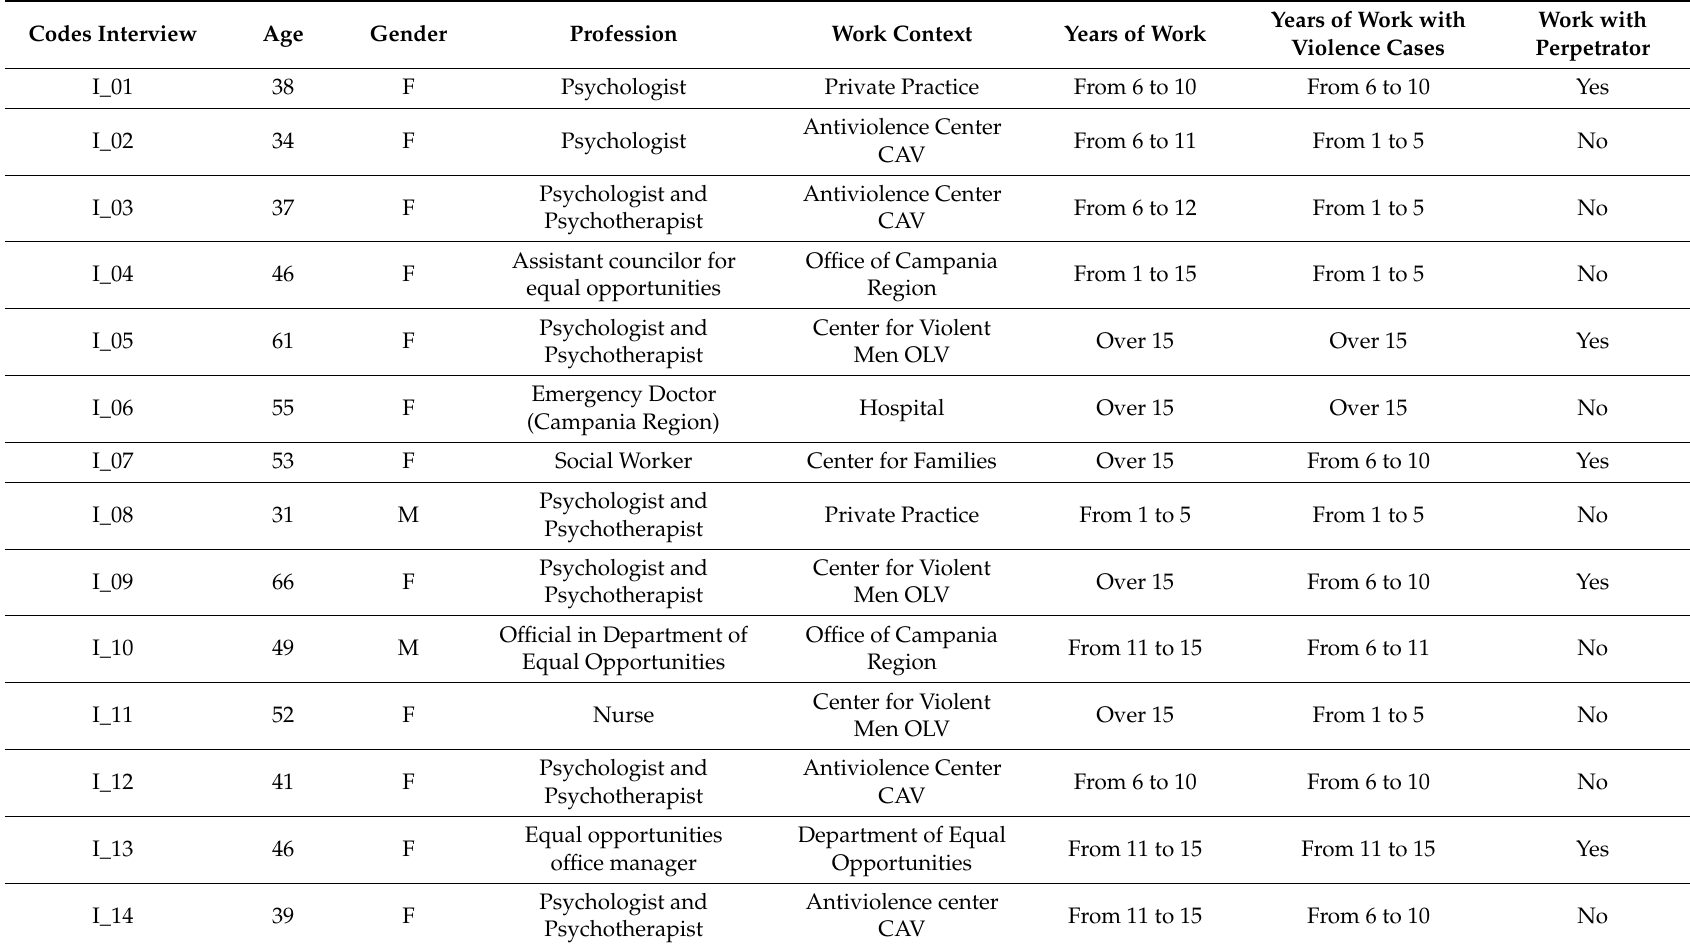
Table 1. Description of